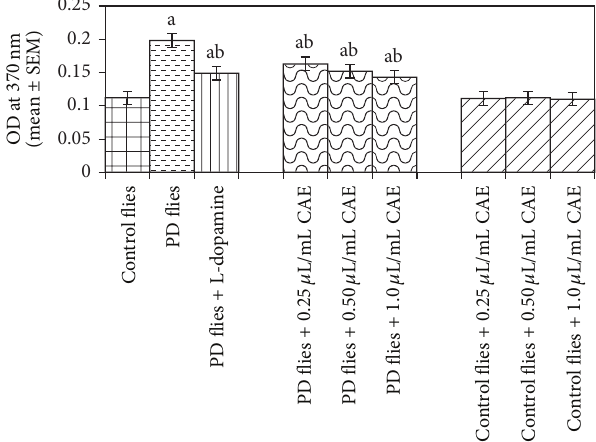
Figure 14: Effect of Centella asiatica extract (CAE) on lipid peroxi- dation measured in the brains of transgenic Drosophila melanogaster after 24 days of the exposure in various treated groups ( a significant with respect tocontrol, 𝑃 -0.01; b significant with respect to PDmodel flies, 𝑃 -0.05). L-Dopa = 10 −3 M; control flies: UAS-alpha-syn; PD flies: elav-GAL4; UAS-alpha-syn.